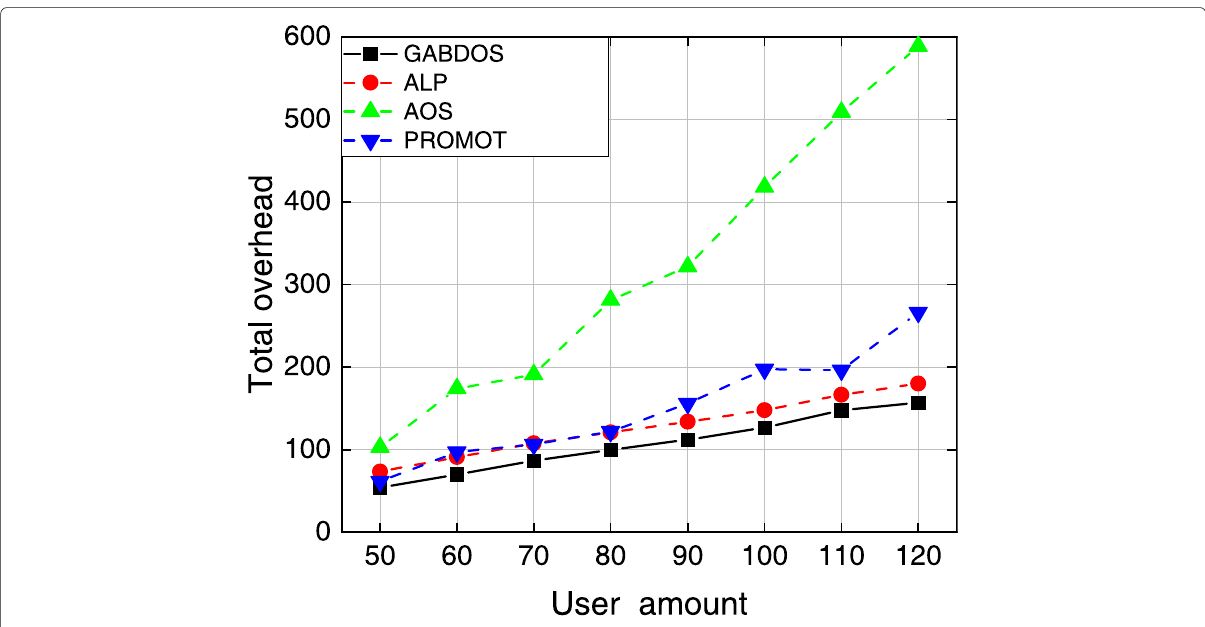
Fig. 5 Total overhead with different user amount